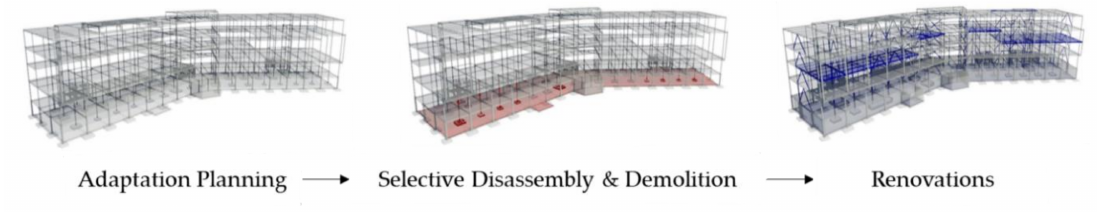
Figure 3. Adaptive reuse process of the case project.